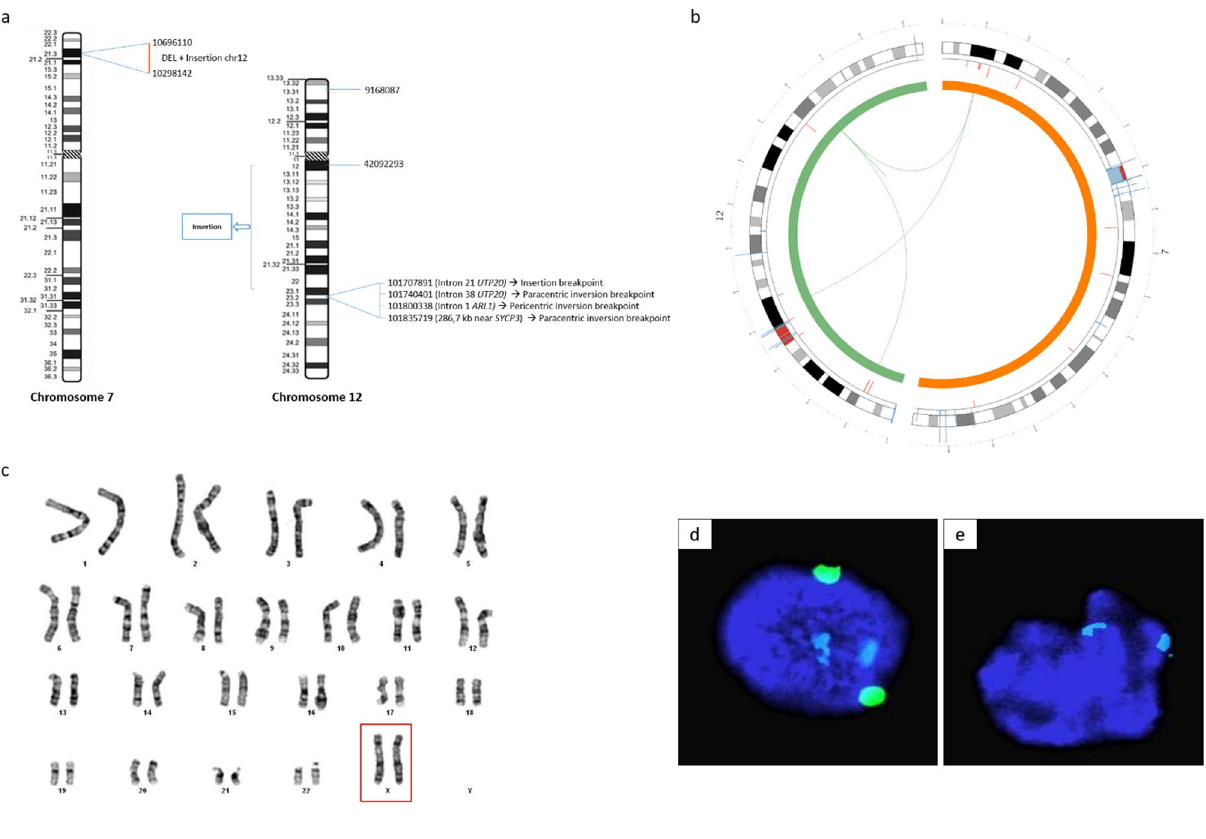
Figure 1. Short-read Whole genome sequencing results of patient 1 and conventional and molecular cytogenetic analysis for patient 2. ( a ) The CCR of patient 1 involved 7 breakpoints: one on the short arm of the derivative chromosome 7 7p21.3 region along with two deletions (chr7:11,801,000–11,791,000 and chr7:10,257,000–10,656,000), one on the short arm of the derivative chromosome 12 12p13.31 region (chr12:9,015,000–9,015,001) and the remaining 5 breakpoints on the long arm of the derivative chromosome 12 (chr12:41,698,000–41,698,001 proximal 12q12 breakpoint; chr12:101,314,000–101,314,001, chr12:101,346,000–101,346,001, chr12:101,406,000–101,406,001, chr12:101,441,000–101,441,001 distal 12q23.2 breakpoints). Genomic positions are described according to the hg38 genome assembly. ( b ) Circos plot showing the 3 events of the CCR of patient 1: the insertion and the pericentric and paracentric inversions. ( c ) G-banded standard karyotype designated as 46,XX (patient 2). ( d ) FISH analysis on buccal swab using centromeric probe for chromosome 18 (blue, 2 signals), chromosomes X (green, 2 signals) and chromosome Y (red, no signal) (patient 2). ( e ) FISH analysis on buccal swab using centromeric probe for chromosome X (blue, 2 signals), chromosome Y heterochromatic region (green, no signal) and SRY gene locus on chromosome Y (red, no signal) (patient